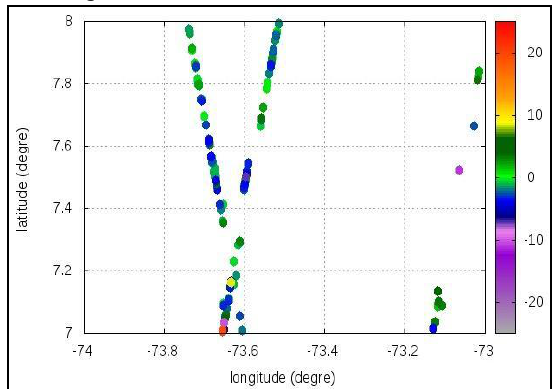
Figure 7 – Vertical accuracy commitment of the AJAX DEM. As shown in the Figure 7 above, our accuracy commitment ranges from 6m LE90 in the flat areas (in green), up to 30m LE90 (in pink) over the extreme slopes. Black dots indicate elevation posts for which no commitment could be